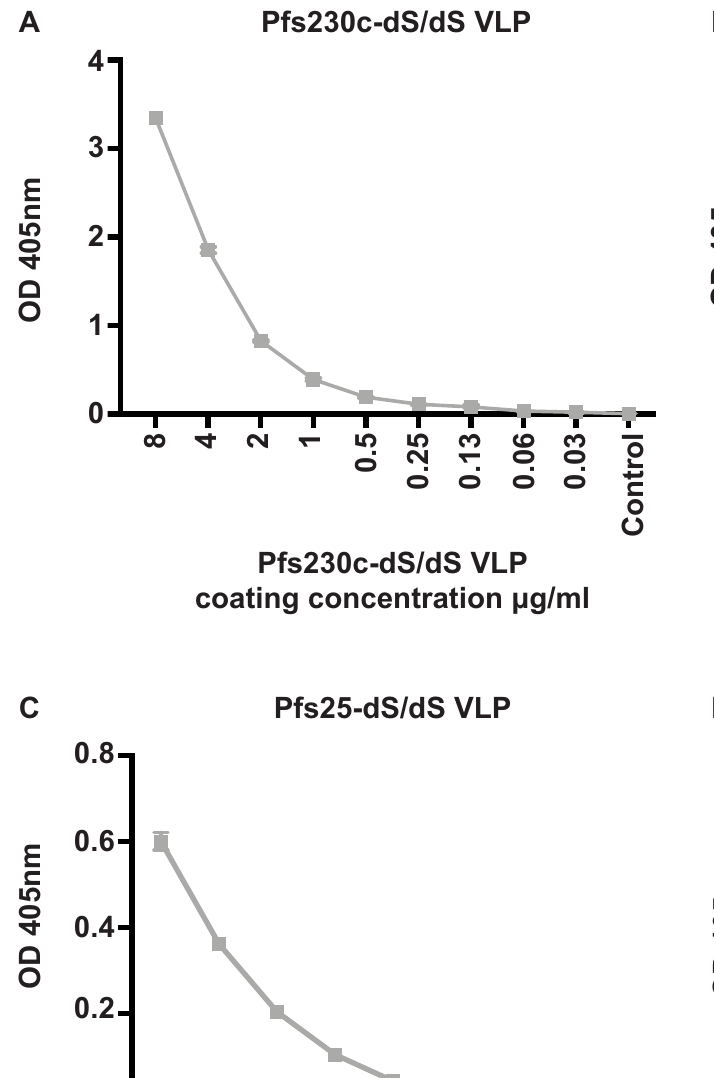
PLOS ONE | https://doi.org/10.1371/journal.pone.0221733 September 10,